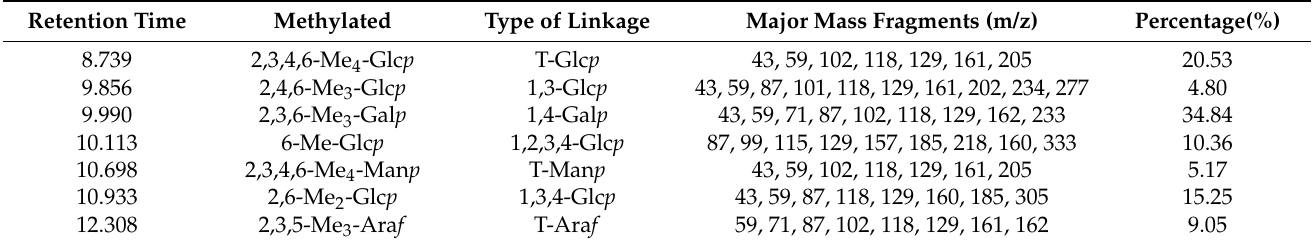
Table 1. Linkage patterns analysis of CPP −